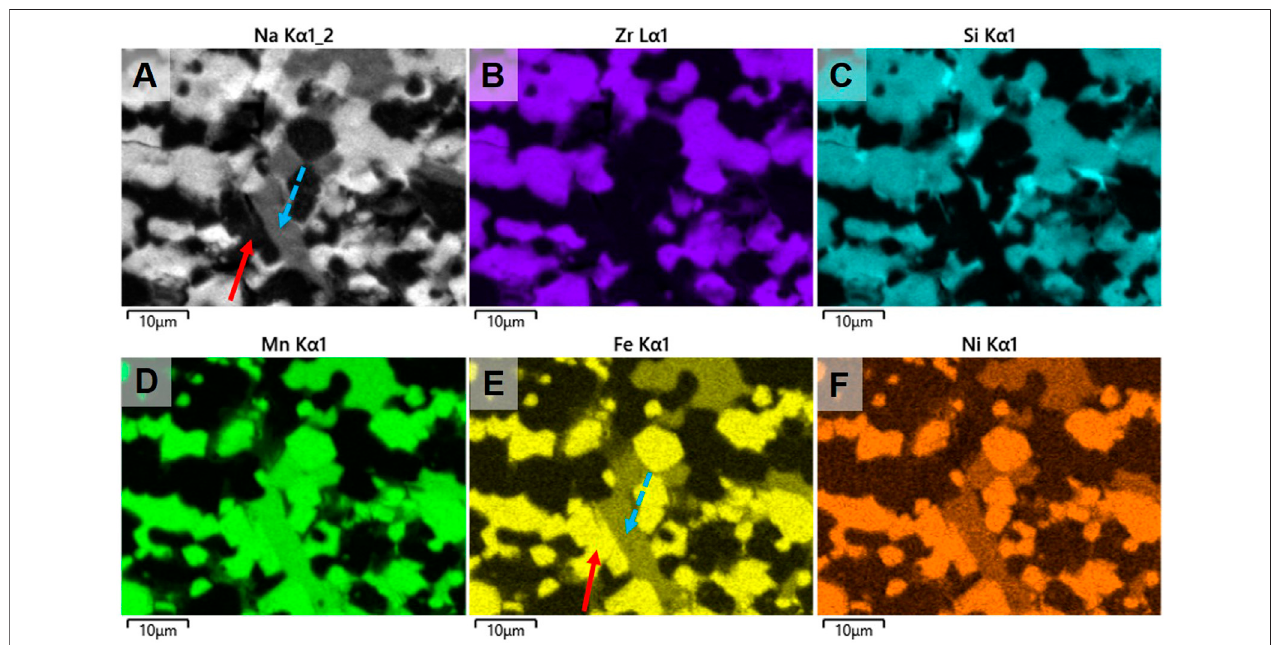
FIGURE 7 | Elemental analysis of NNFM/NaSICON co-sintered specimen using EDX. Arrows highlighting Na rich (blue) and Na poor (red) NNFM regions.